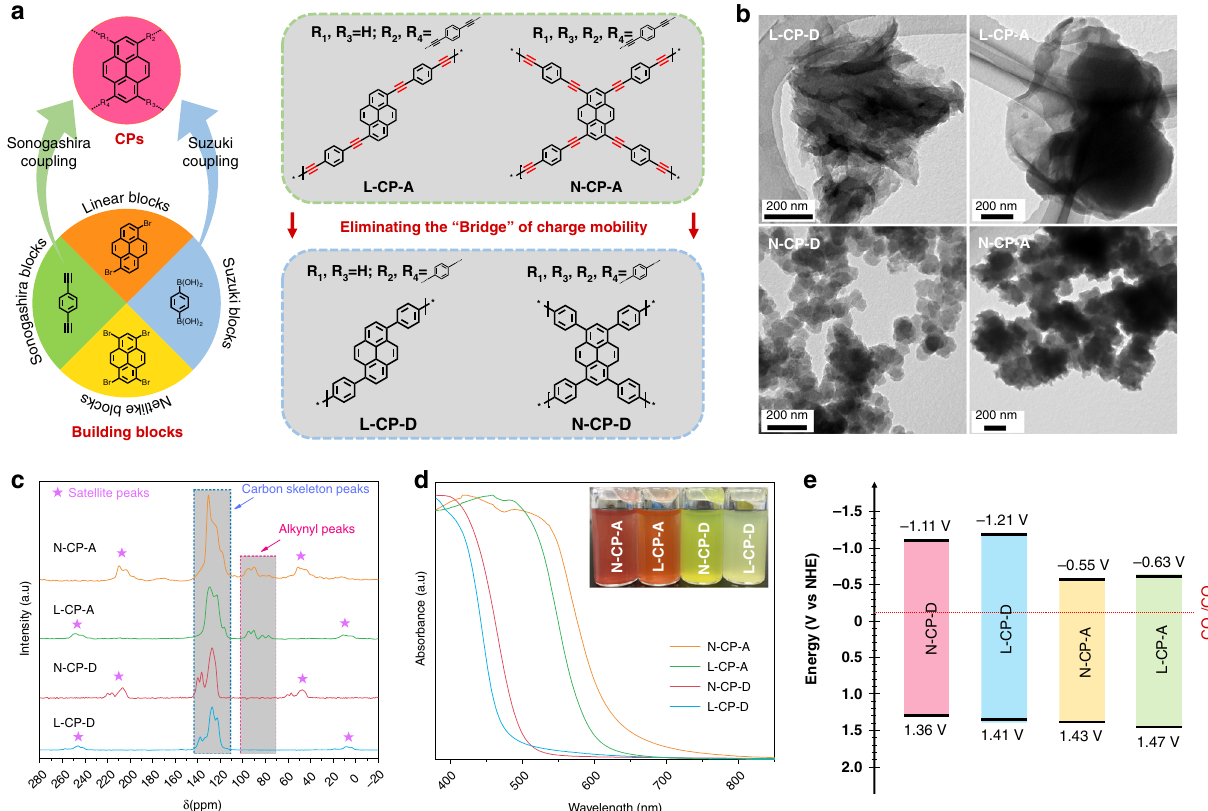
Fig. 1 Preparation and characterization of the CPs. a Illustration of synthesis and the strategy of eliminating the charge-transfer bridge. b TEM images of CPs. c Solid-state 13 C corss-polarization/magic angel spinning nuclear magnetic resonance (CP/MAS NMR) spectroscopy of CPs. d Solid-state UV/Visible diffuse re fl ectance spectra (DRS) of CPs, Inset: CPs dispersed in an acetonitrile/water (7:3) mixture. e Highest occupied molecular orbital (HOMO) and lowest unoccupied molecular orbital (LUMO) band position diagram for CPs obtained from cyclic voltammetry (CV) and